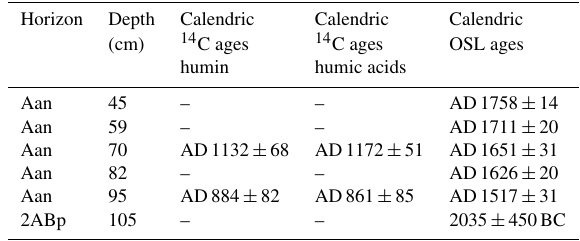
Table 3. 14 C and OSL dates of the plaggic deposits of